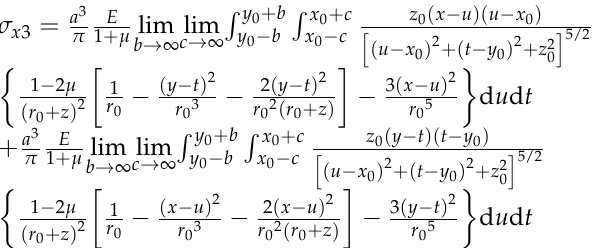
. Figure 3. The model of uniform expansion of the grouting area. The rate of volume expansion of the soil ( Q ) before and after grouting can be de- fined as